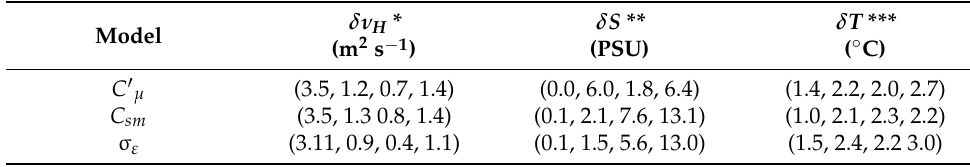
Table 5. RMSE calculated (25) for the four stations (in parentheses) and for some non-universal k- ε / Sma parameters, relatively to the reference values of Table 4.